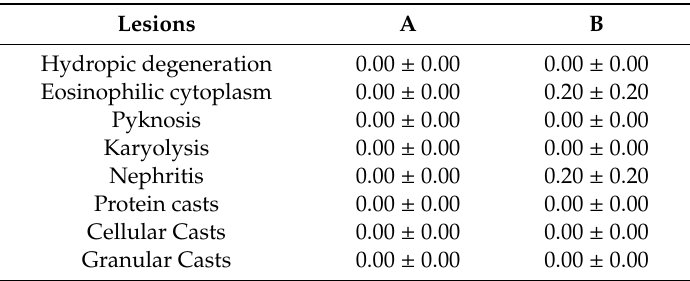
Table 6. Kidney lesion scores (mean ± SEM) for female ICR mice in acute toxicity study of